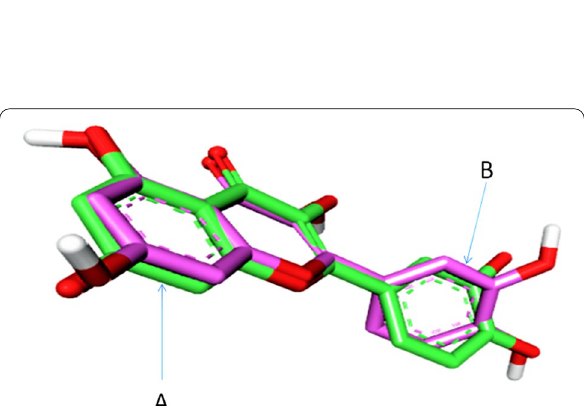
Fig. 5 Stick model superimposition of coordinates of co-crystallized ( A ) and docked ( B ) conformations of quercetin. The two structures were superimposed in the Discovery Studio Visualizer’s workspace and RMSD calculated, setting A as reference. The superimposed structures overlaid with a high degree of correspondence, differing only with an RMSD of 1 Å